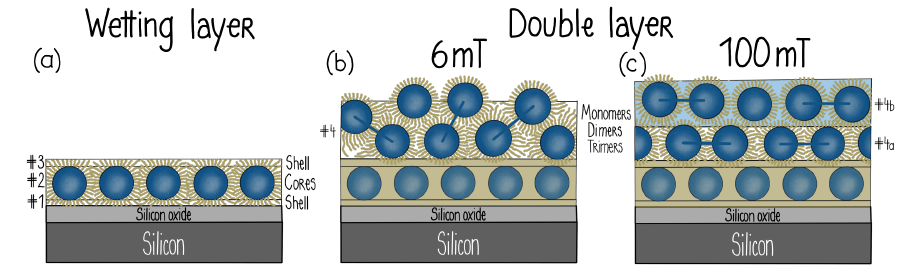
Figure 9. Schematic drawings of NP ordering on an APTES-coated substrate. ( a ) NP wetting layer (# 1–3), ( b ) double layer of tilted NP dimers above the wetting layer in a 6 mT field and ( c ) two distinct NP layers that form above the wetting layer in a 100 mT field